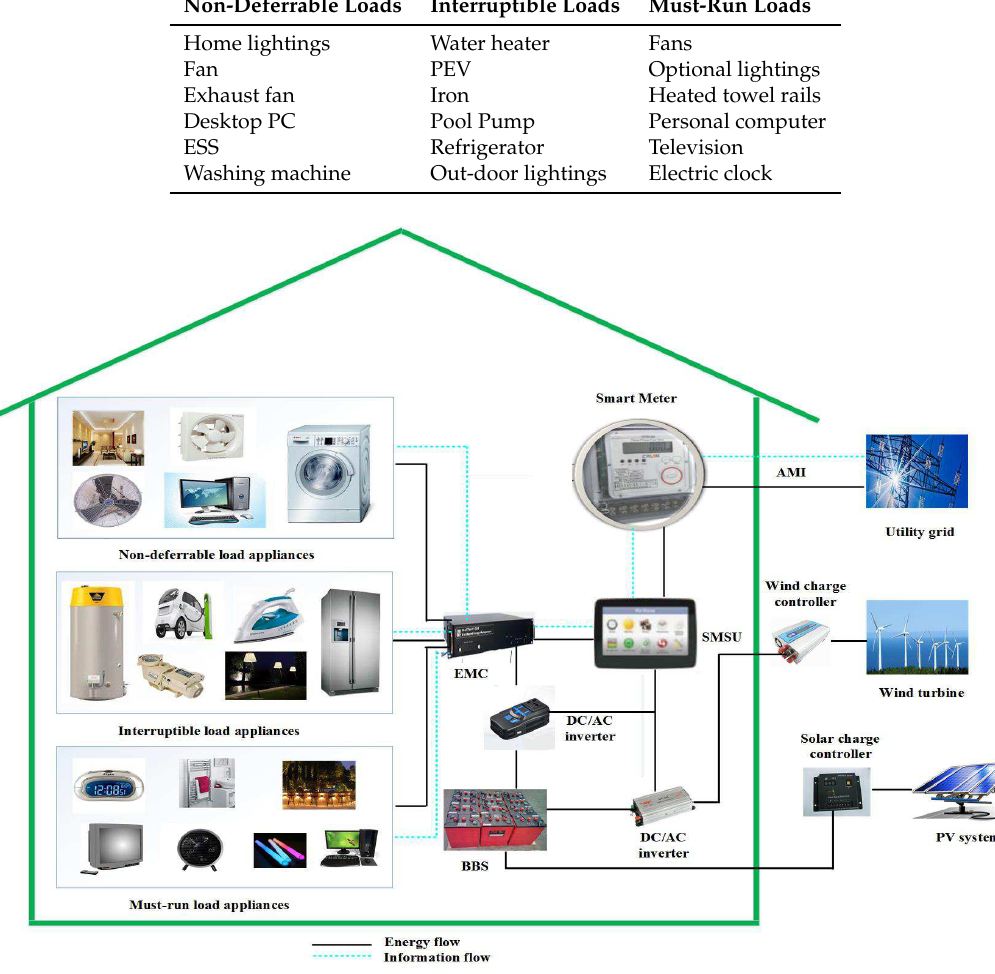
Figure 2. Block diagram of system